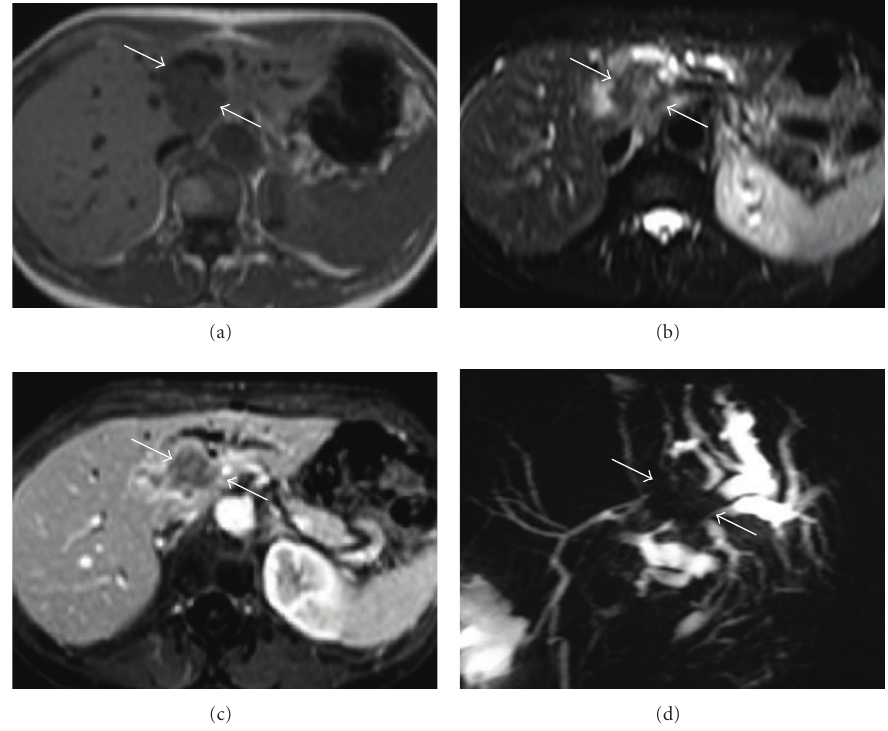
Figure 1: This figure demonstrates a mass lesion located in the left lobe of the liver close to hilus (a) hypointense on T1-weighted MR image, (b) heterogenous hyperintense on T2-weighted image, and (c) heterogenous contrast enhancement on contrast-enhanced fat-saturated T1- weighted image. (d) MRCP image demonstrates the mass that originated from left main bile duct and causes significant bile duct dilatation at the periphery of the liver (arrows). The lesion was considered to be a cholangiocarcinoma with MRI and MRCP findings and also confirmed surgically.